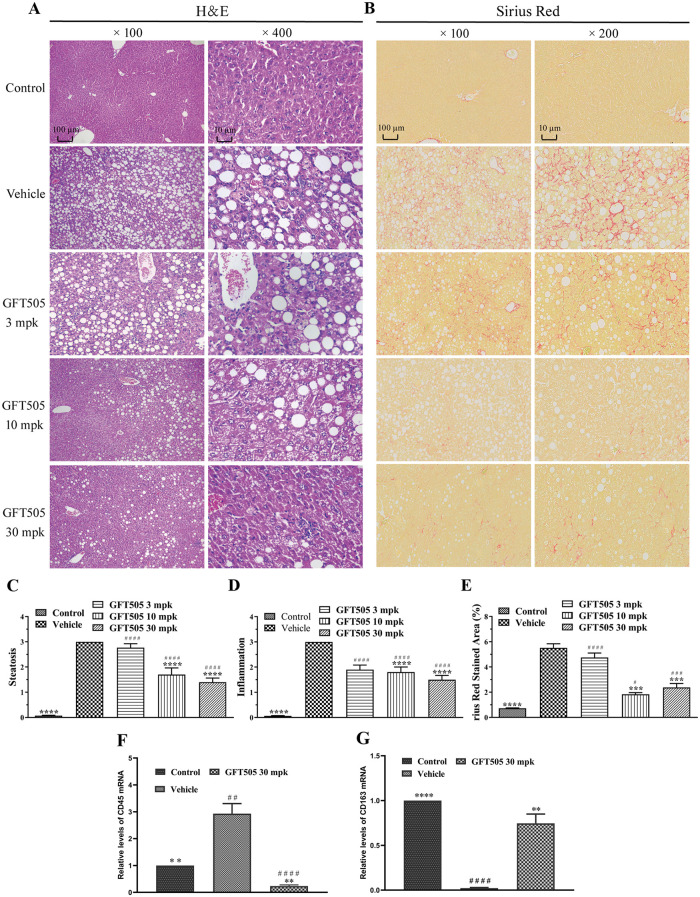
GFT505 attenuated hepatic steatosis, inflammation and fibrosis in CDAHFD-fed C57BL/6 mice.(A) Results of liver Hematoxylin and Eosin (H&E) staining. (B) Results of liver Sirius Red staining. (C, D) NASH/NAFLD Clinical Research Network scoring system and the scores in steatosis and inflammation. (E) Sirius red stained area quantification. (F) Relative mRNA expression of the CD45 by RT-qPCR. (G) Relative mRNA expression of the CD163 by RT-qPCR; Control, normal diet; Vehicle and GFT505 groups, CDAHFD diet; Statistic analysis were performed using one-way ANOVA; Values were means ± SEM; *p < 0.05, **p < 0.001, compared with vehicle group; #p < 0.05, ##p < 0.001, comparing with control group; n = 10.